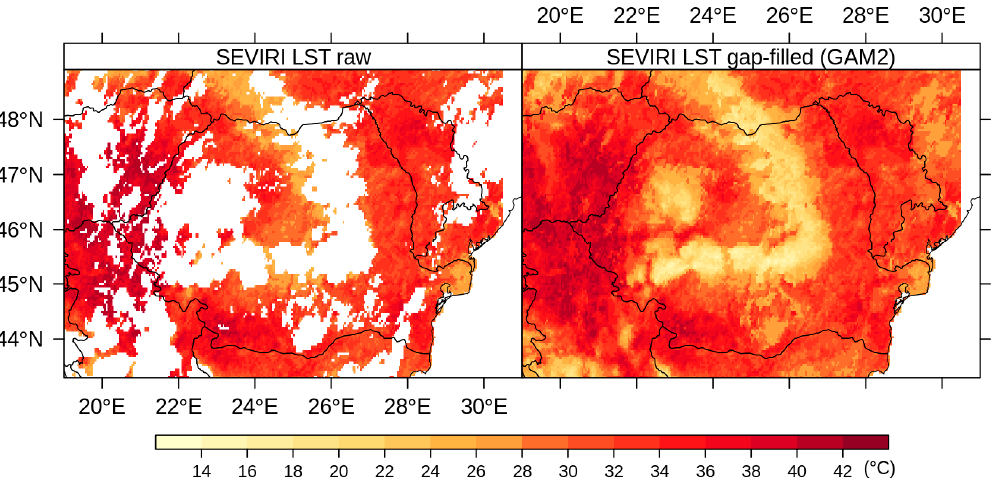
Figure 8. SEVIRI LST (° C) data from July 20, 2017, 4:00 pm UTC: original image (left) and completed data (right).